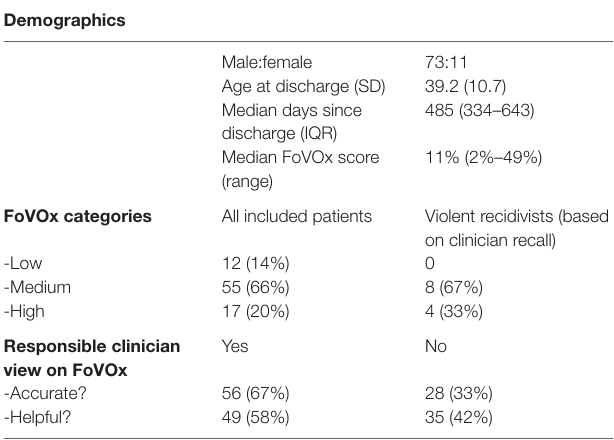
TABle 1 | Sample characteristics and FoVOx